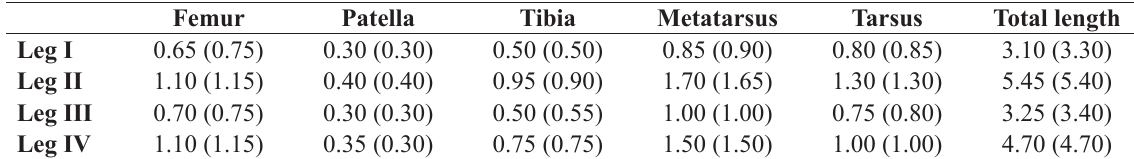
Table 6. Length of appendage-segments in millimeters (trochanters not presented) in N. relictum Gruber & Martens, 1968 stat. nov. from the vicinity of Tappenkarsee, Obertauern, Austria: ♂ holotype (♀) (from Gruber & Martens Femur Patella Tibia Metatarsus Tarsus